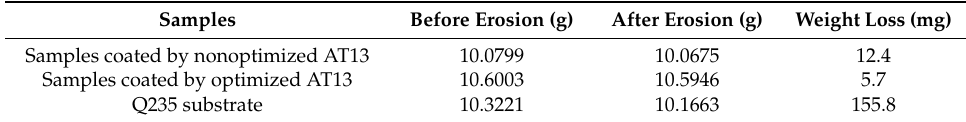
Figure 12. Surface morphologies of the AT13 coating prepared at ( a ) optimized and ( b ) nonoptimized parameters and ( c ) Q235 substrate after erosion with ( d ) the corresponding magnified image. Table 6. Weight of the samples before and after erosion.